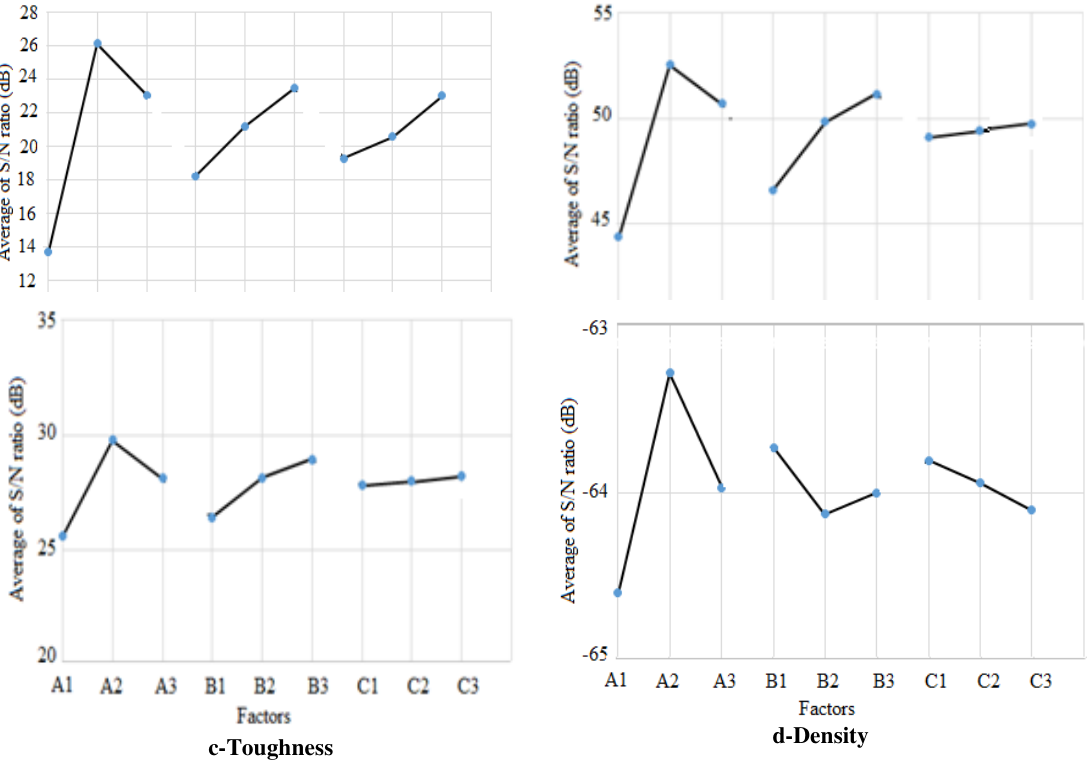
Fig. 3. Main effect